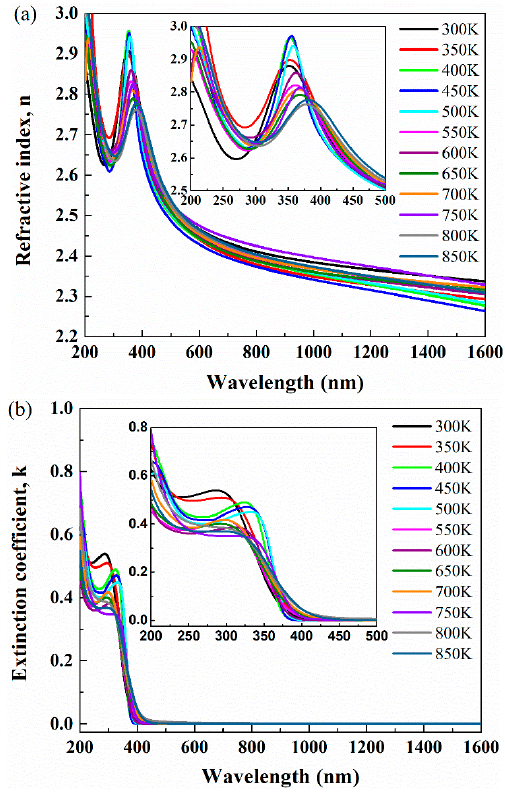
Figure 8. Fitted optical constants of sample S0 with temperature varied from 300 K to 850 K: ( a ) refractive index vs. wavelength; ( b ) extinction coefficient vs. wavelength.